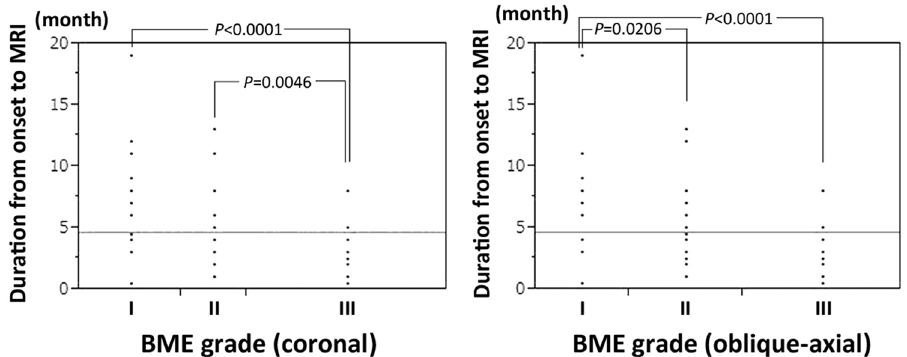
Figure 7. Relationship between the degree of extension of BME (BME grade) and the duration from the onset of hip pain to MRI examination. Duration from the onset of hip pain to MRI examination in the grade III were significantly shorter than grade I on both coronal and oblique-axial planes.